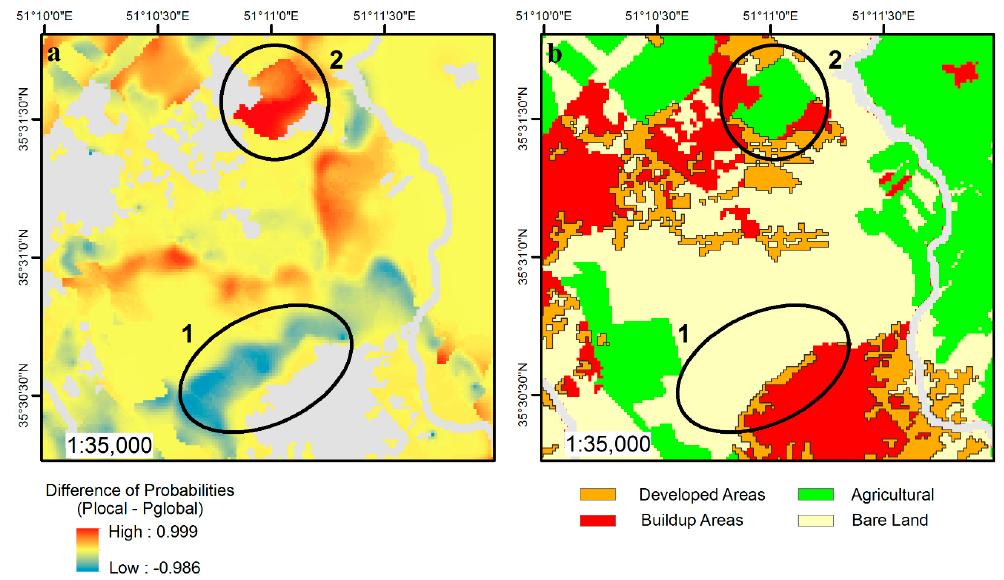
Figure 10. ( a ) Difference between the local and global probabilities and ( b ) the land use map.